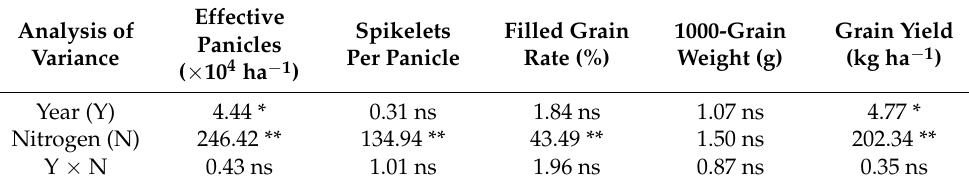
Table 12. Analysis of variance of grain yield and yield